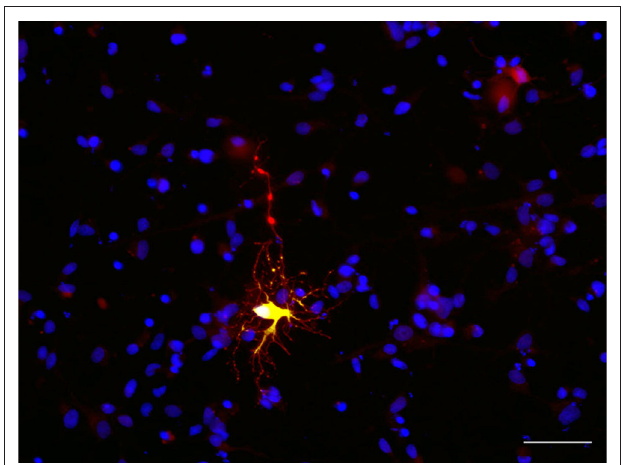
FIGURE 8 | Human fetal radial glia cell in culture differentiates as an oligodendrocyte progenitor. BLBP-Cre/Floxed-YFP transfected cell (green) co-labeled with O4 (red) after 7 days in culture. Scale bar: 20